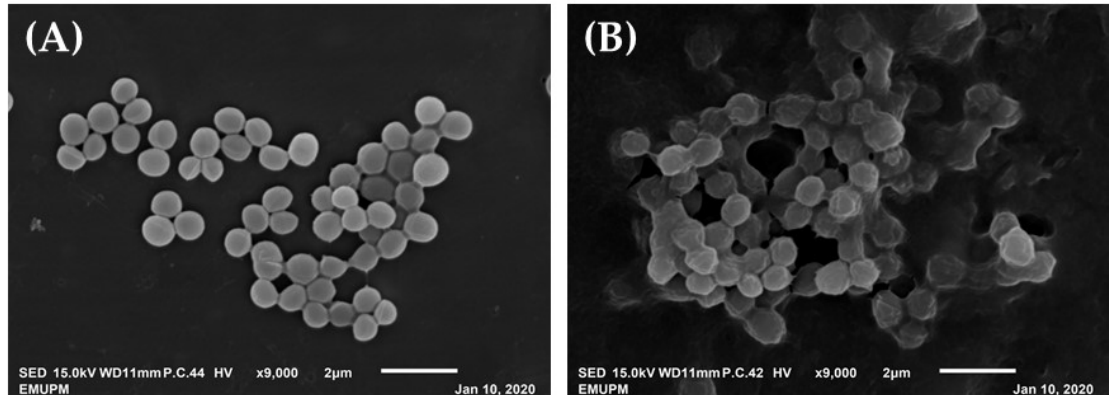
Figure 5. Scanning electron micrograph of ( A ) untreated and ( B ) treated with 1% of compound 9 on the clinical MRSA 172918 cells for two hours.